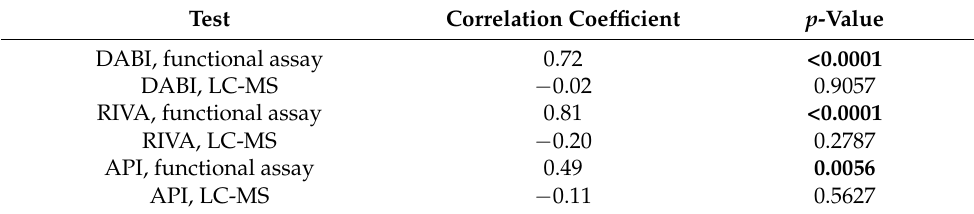
Table 2. Spearman correlation coefficient values and p -values of all tests with LA ratio. Statistically significant p -values are shown in